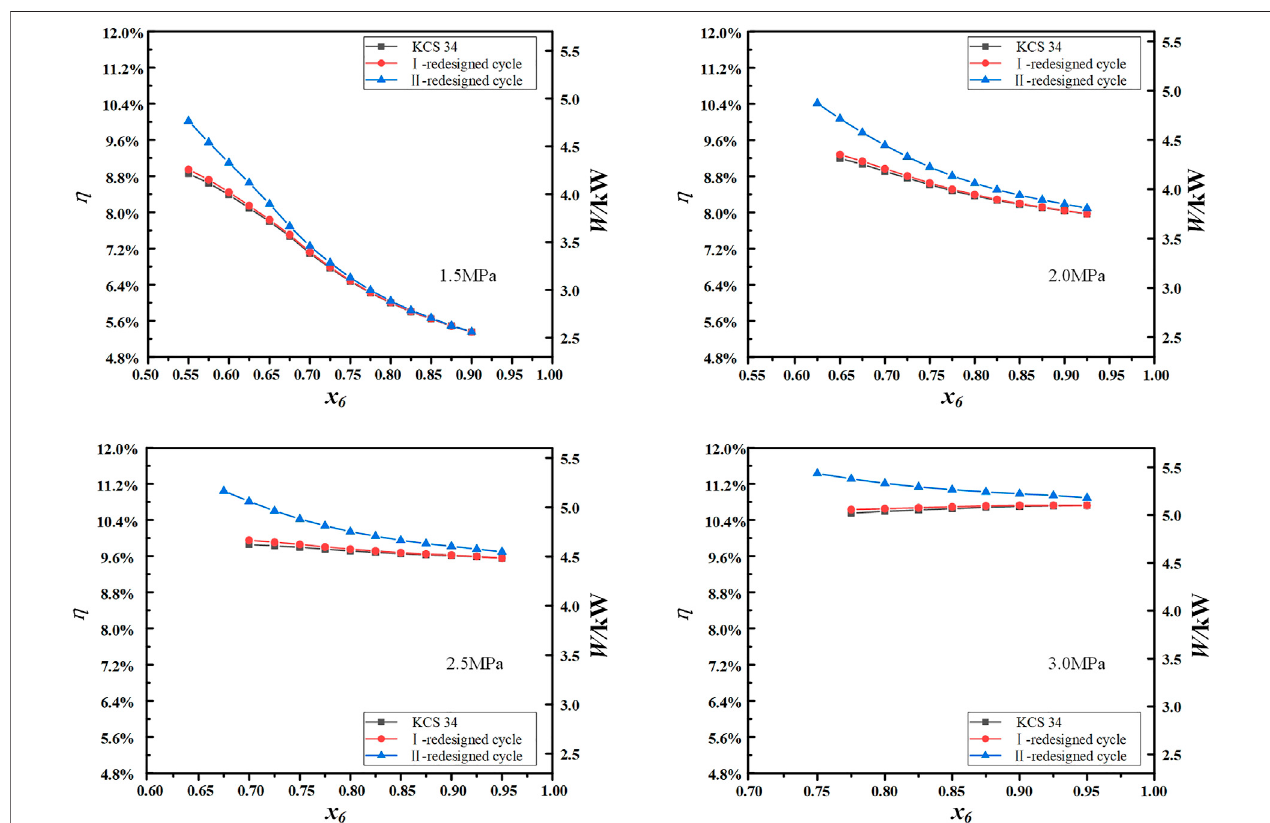
FIGURE 8 | The variation of cycle thermal ef fi ciency and net work with the evaporation pressure and ammonia-water concentration.